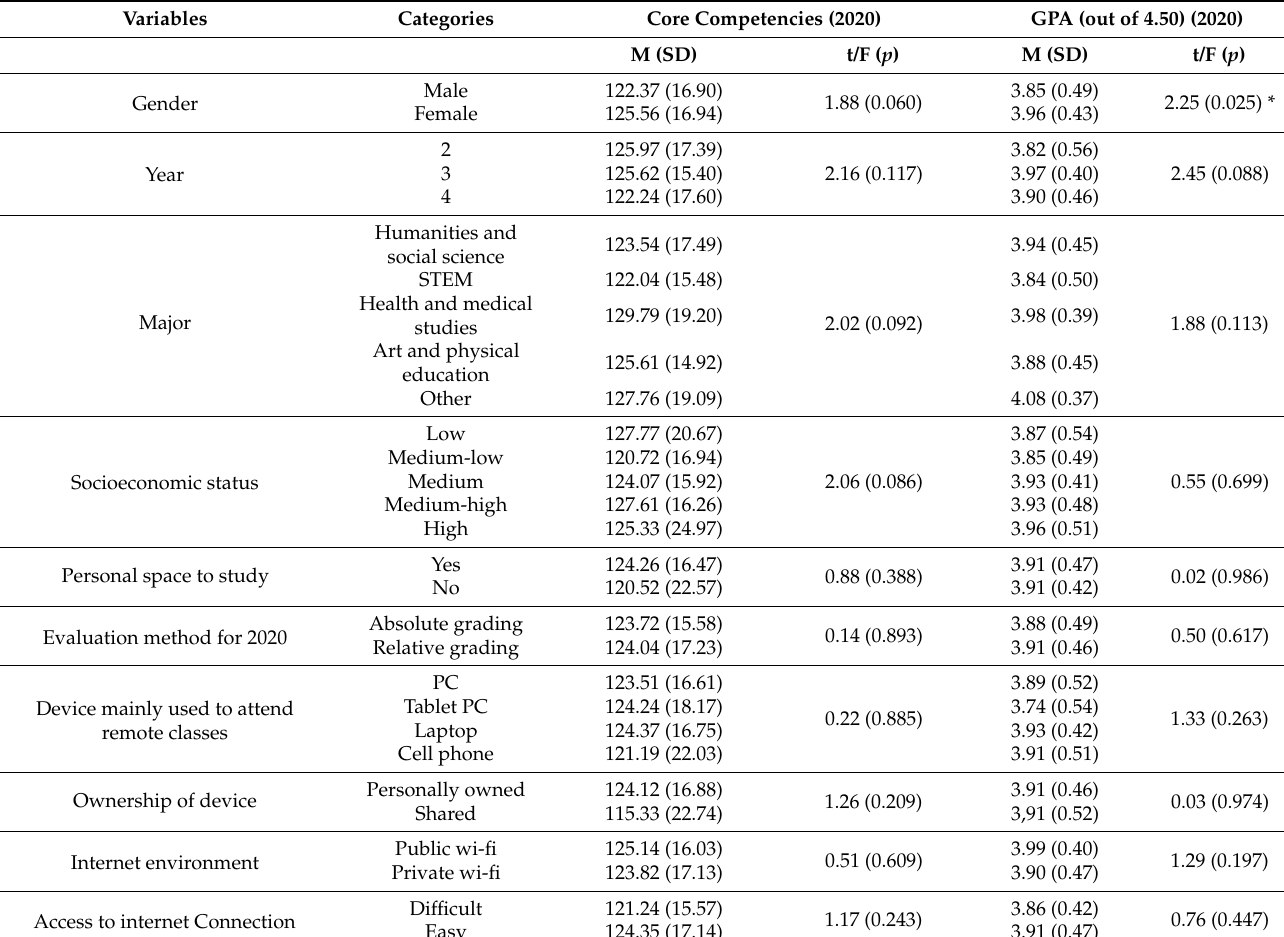
Table 2. The difference in core competencies and academic performance according to participant characteristics.